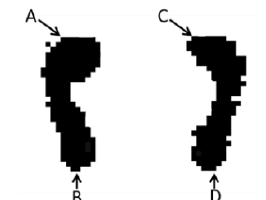
(10) Figure 6. Binarization of the result of the effective data of the foot sole. 2.3.4. Automatic Recognition and Location of Foot Endpoints In order to realize the automatic measurement of the arch index, an important premise is to know the foot length, to extract the key endpoints of the left and right soles. Thus, for the left sole, from left to right, from top to bottom, all pixel points are traversed in turn and the location of the first non-zero pixel point is recorded as A (i, j) , and the coordinates of the last non-zero point are recorded as B (i, j) , as expressed as Equations (11) and (12). In the same way, the right sole’s endpoints C (i, j) and D (i, j) can be also obtained, as expressed as Equations (13) and (14), respectively, where i and j are the endpoints’ row coordinate and column coordinate, as shown in Figure 7. 43 25 0 0 ( ,